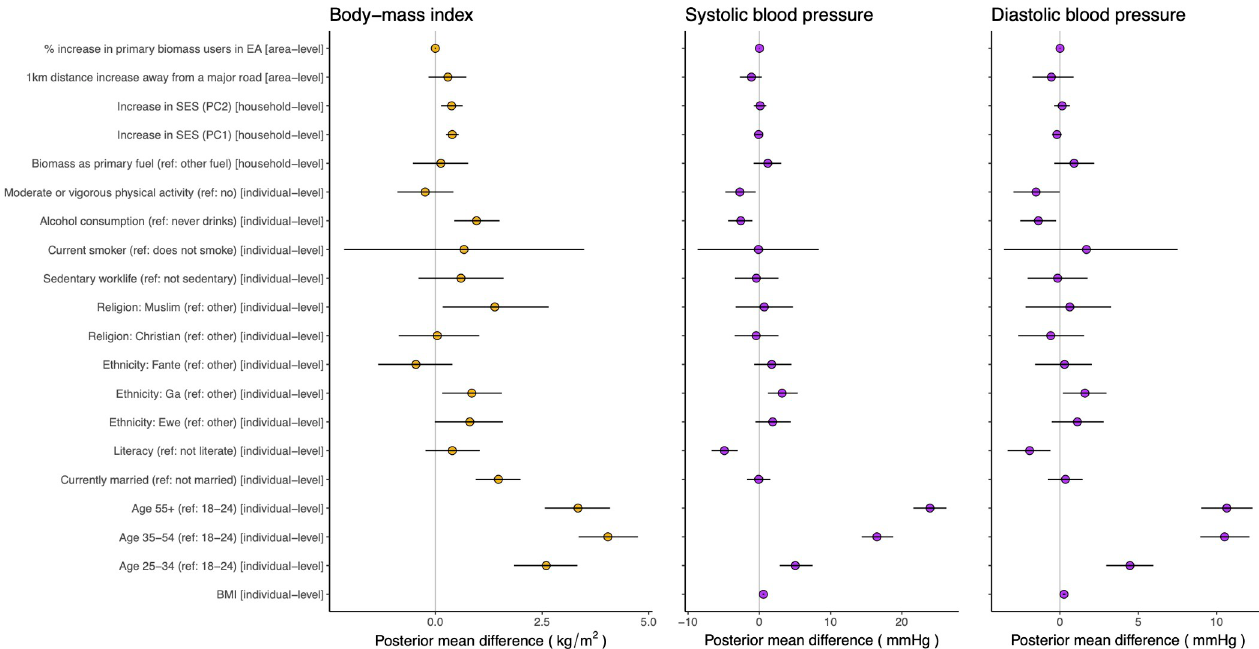
Fig 2. Associations of BP and BMI with demographic, behavioural, socioeconomic, and environmental factors in the WHSA. The figure includes the extended variable set. For each variable, the figure shows the posterior mean association and the 95% CrI. Associations among the core variable set are in Fig B in S1 Text. The prevalence of women who smoke tobacco in Accra was very low ( < 1% in WHSA), resulting in the large uncertainty around the mean associations. 95% CrI, 95% credible interval; BMI, body-mass index; BP, blood pressure; EA, enumeration area; PC 1 and 2, principal components 1 and 2; ref, reference for categorical variables; SES, socioeconomic status; WHSA, Women’s Health Study of Accra.